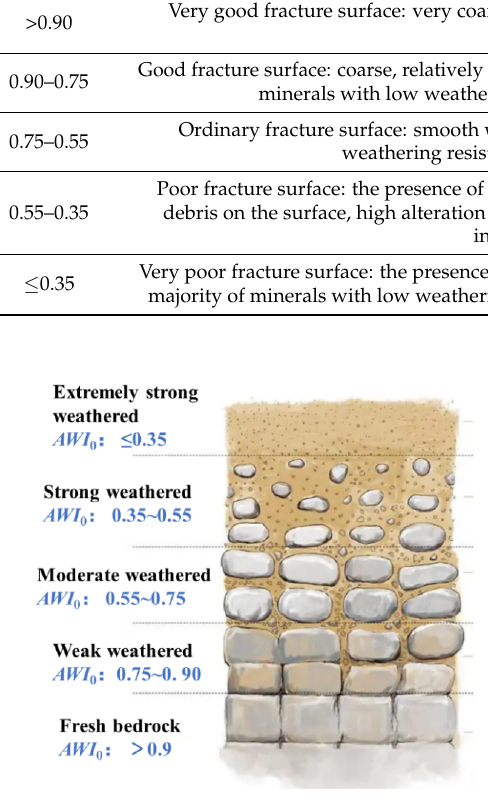
Figure 1. Schematic diagram of rock weathering.